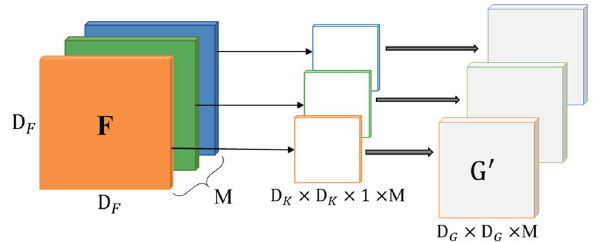
Figure 2. Depthwise convolution.